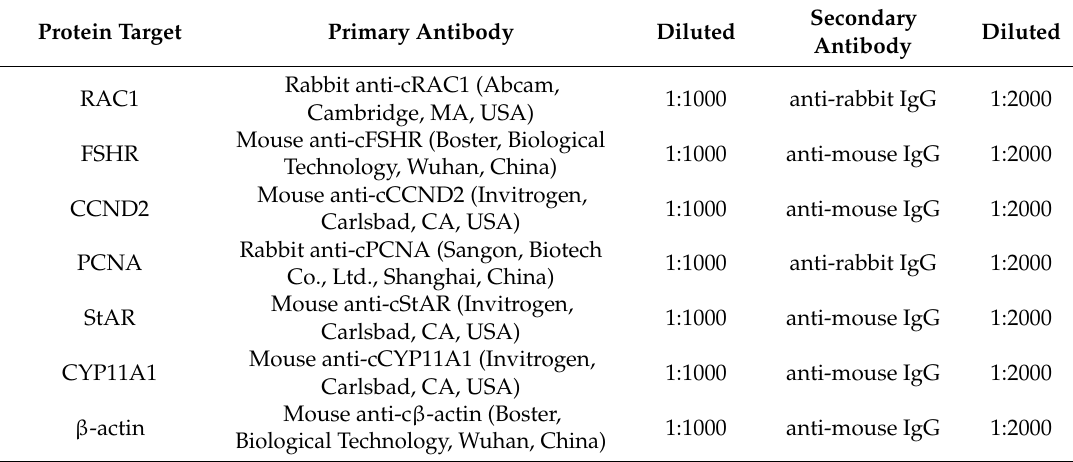
Table 2. Western blotting